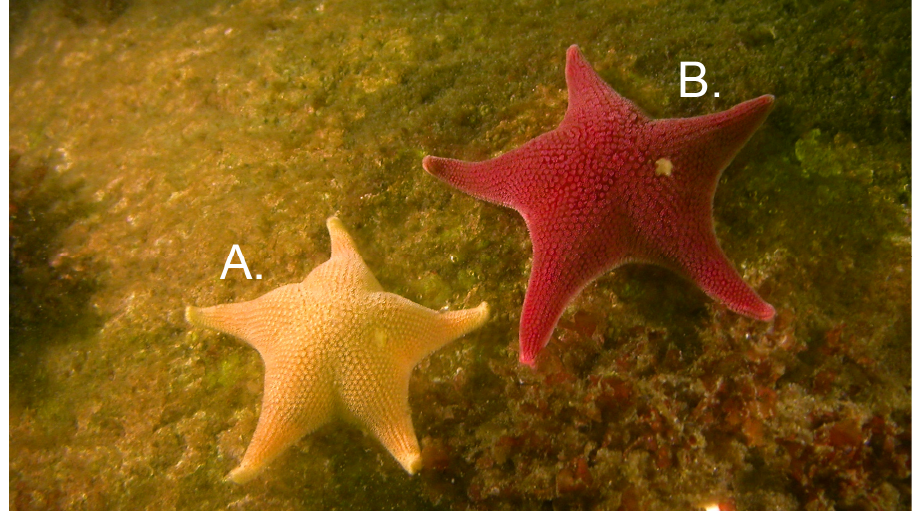
Figure 5. Two specimens of Odontaster validus ( A , B ) photographed by Stefano Schiaparelli during a dive in Road Bay (Terra Nova Bay area) at ~20 m depth. The orange yellow specimen (( A ) in figure) corresponds to the sequenced MNA-02902 (also in Figure 4).